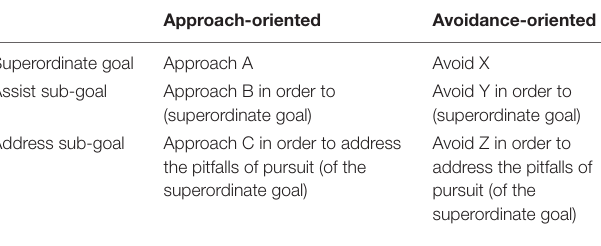
TABLE 1 | Summary of approach- and avoidance-oriented superordinate and